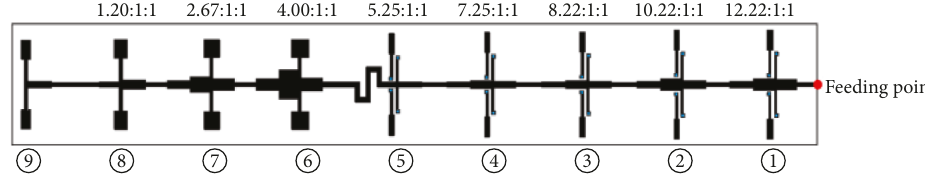
Figure 7: Division ratio of each stage of feeding network of half